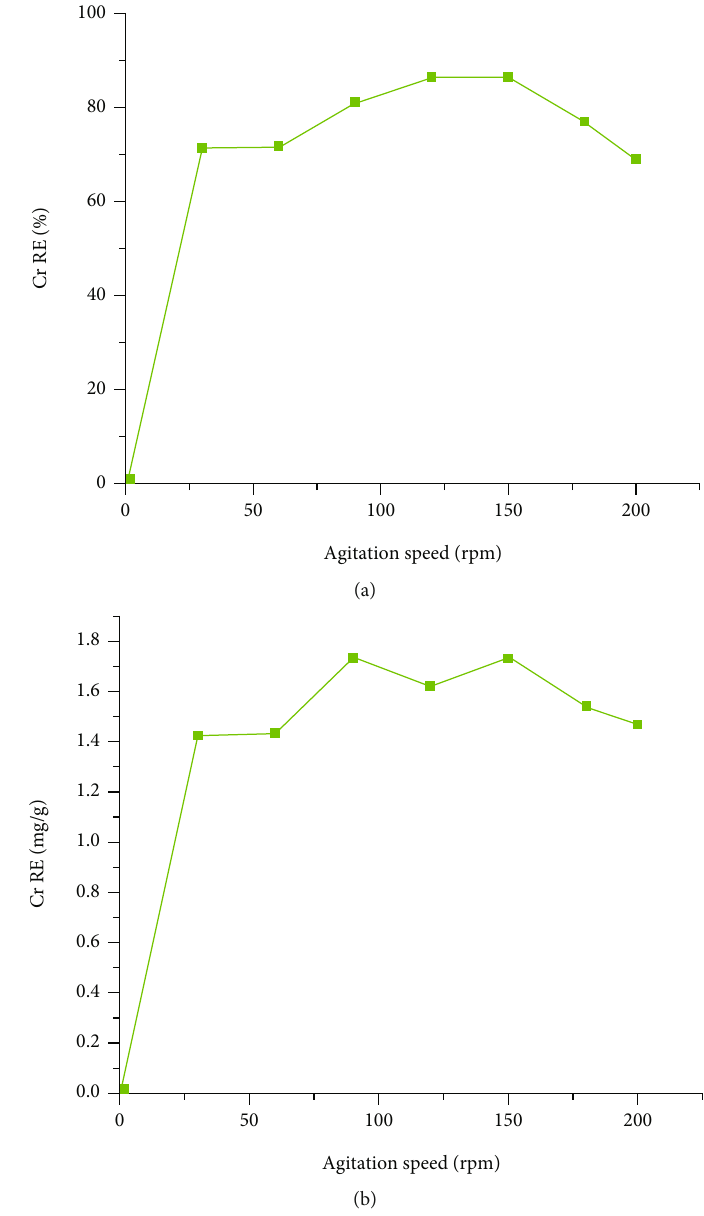
Figure 5: Agitation speed e ff ects on Cr (a) % RE and (b) mass adsorption e ffi ciency (mgg -1